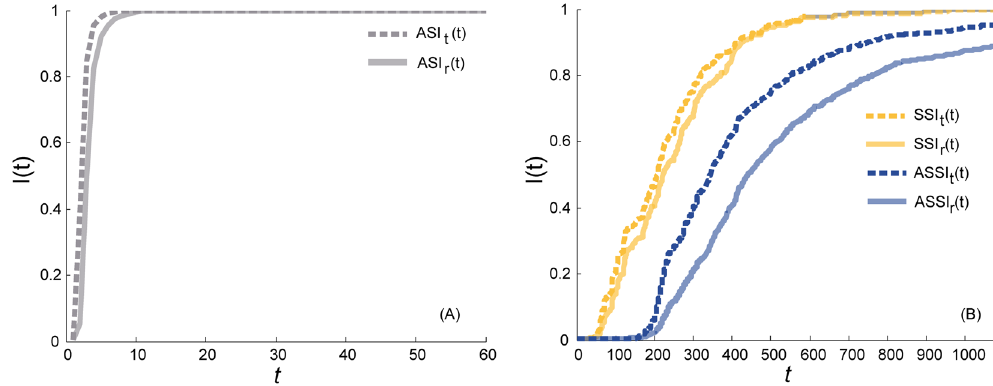
Figure 5. Comparison of propagation patterns within different SI spreading models on CAN. ( A ) Spreading pattern in ASI. ASI t ( t ) and ASI r ( t ) denote the ratios of infected nodes in ASI at time t in the case of targeted and random infections, respectively. ( B ) Spreading patterns in ASSI and SSI. SSI t ( t ), SSI r ( t ), ASSI t ( t ), ASSI r ( t